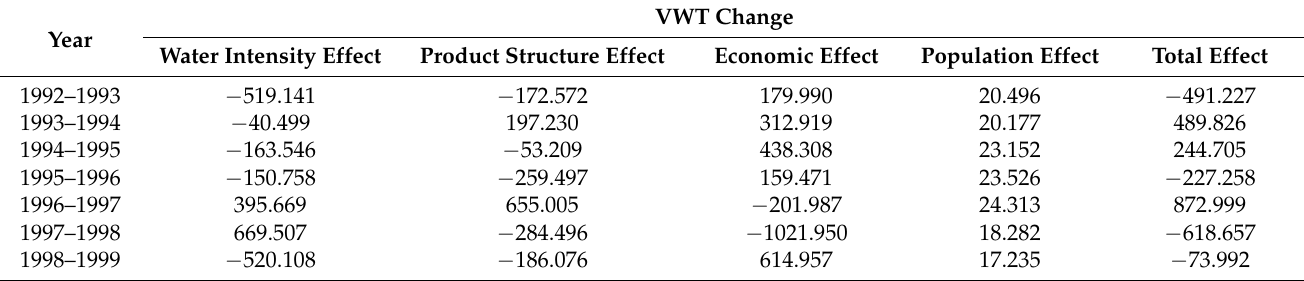
Table A6. The logarithmic mean divisia index (LMDI) analysis of soybean virtual water trade (VWT) change in South Korea (million m 3